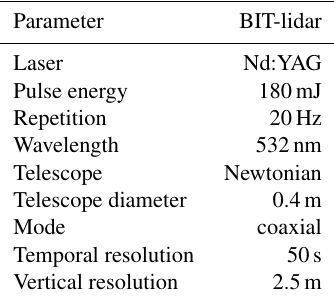
Figure 1. Theoretical schematic of the k -means clustering. The Eu- clidean distance dis (x i ,x j ) between two given signal points x i and x j , with coordinates (GM i , h i ) and (GM j , h j ), in the cluster Ci and cluster